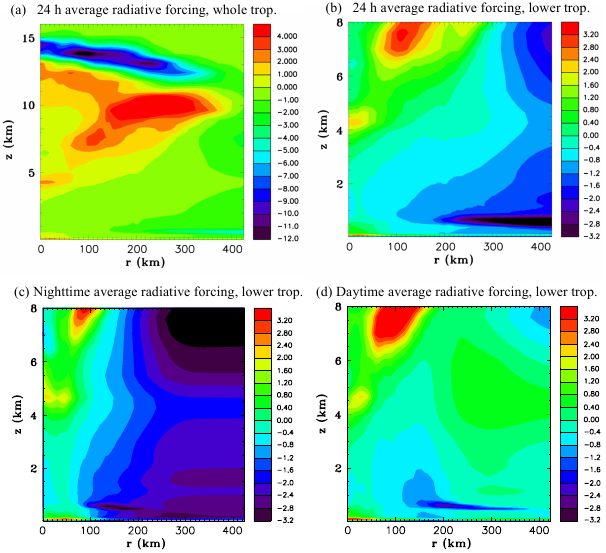
Figure 24. Time and azimuthally averaged radiative flux conver- gence for Experiment 13: the full physics simulation with radiation activated in the whole domain case. (a) 24h average from 24 to 48h shown for the whole troposphere, (b) 24h average from 24 to 48h shown for the lower troposphere, (c) 6h nighttime average from 15 to 21h shown for the lower troposphere, and (d) 6h daytime average from 24 to 30h shown for the lower troposphere ( × 10 − 5 Ks − 1 ).